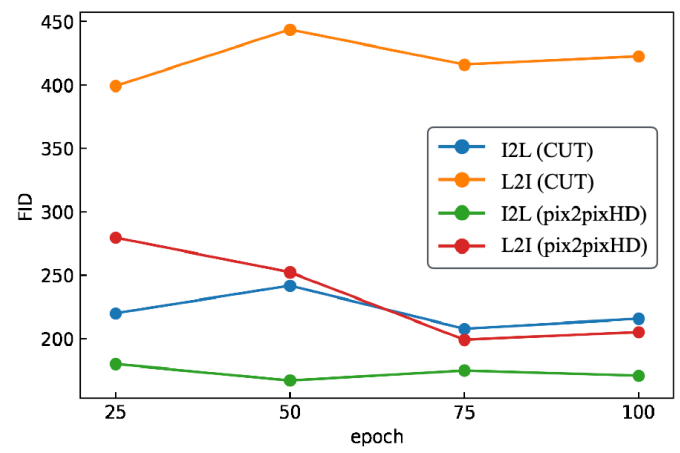
Figure 10. Time-series FID trends for the respective GANs in Rice blast.